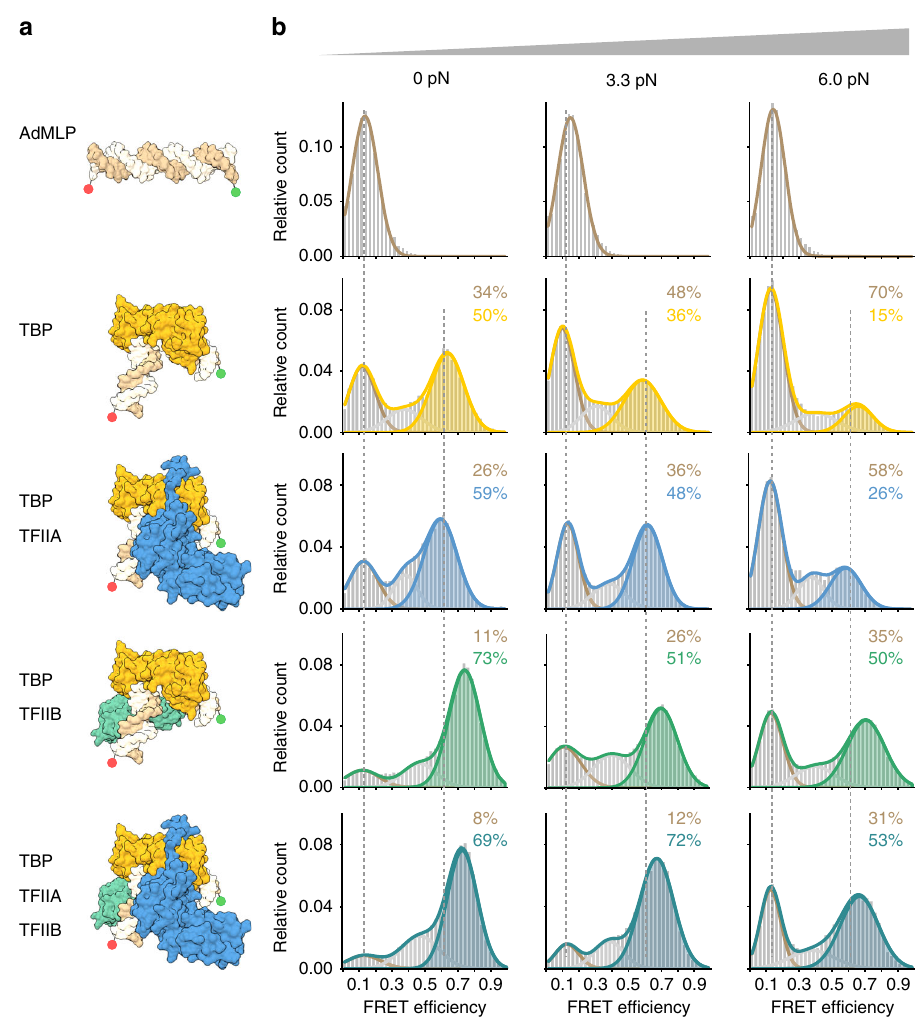
Fig. 2 Force dependency of promoter binding of RNAP II initiation factors at a canonical RNAP II promoter. a Structural models (PDB: 5IYB) of the adenovirus major late promoter (AdMLP, brown) in an unbent conformation and the bend state bound by TBP (yellow), TFIIA (blue) and TFIIB (green). b Single-molecule FRET measurements on diffusing molecules monitor TBP-induced DNA bending after the addition of TBP (20 nM), TBP and TFIIA (2 µ M), TBP and TFIIB (200 nM) or TBP, TFIIA and TFIIB to the AdMLP DNA origami force clamps at increasing forces (0, 3.3 and 6.0 pN). FRET ef fi ciency histograms showing the relative distribution between the unbent DNA state (low FRET state, E = 0.12, brown) and TBP-induced bent state (high FRET population, E = 0.63 (TBP only and TBP/TFIIA, yellow and blue, respectively), E = 0.72 (TBP/TFIIB, green and TBP/TFIIA/TFIIB, teal)). Low and high FRET populations were fi tted with a Gaussian distribution. Each measurement was carried out at least three times. See also Supplementary Fig. 5 and Supplementary Table